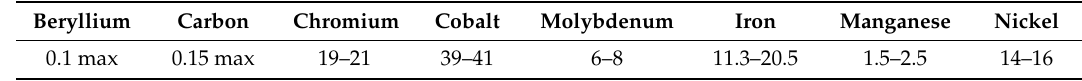
Table 2. Composition of Elgiloy (%).